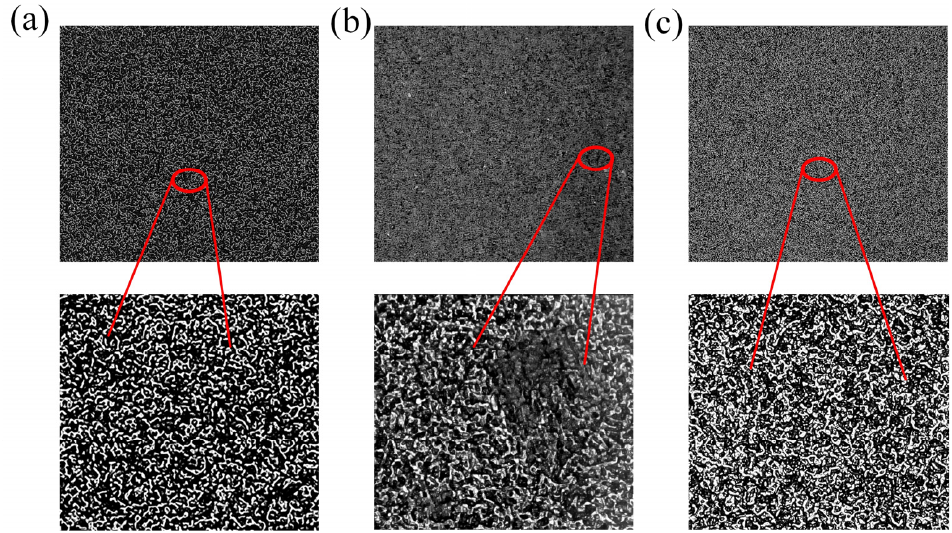
Figure 5. ( a ) Microstructure of 800 mesh sandpaper; ( b ) surface microstructure of MWCNT/PDMS layer without oily release agent in fabrication; and ( c ) MWCNT/PDMS layer with complete spinous microstructure.